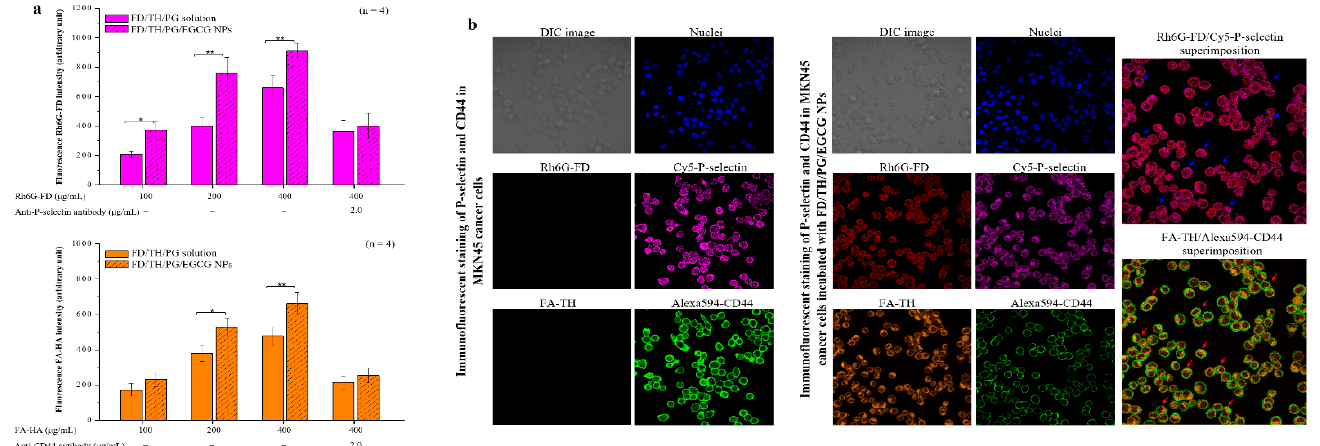
Figure 3. ( a ) Binding assays of fluorescence Rh6G-FD and FA-TH to immobilized recombinant P-selectin and CD44 protein. Data is expressed as mean ± SD ( n = 4). Asterisk symbols * and ** represent statistically significant differences with p value < 0.05 and < 0.01, respectively; ( b ) Immunofluorescence staining of P-selectin and CD44 proteins in MKN45 cancer cells incubated with Rh6G-FD/FA-TH/PG/EGCG NPs.